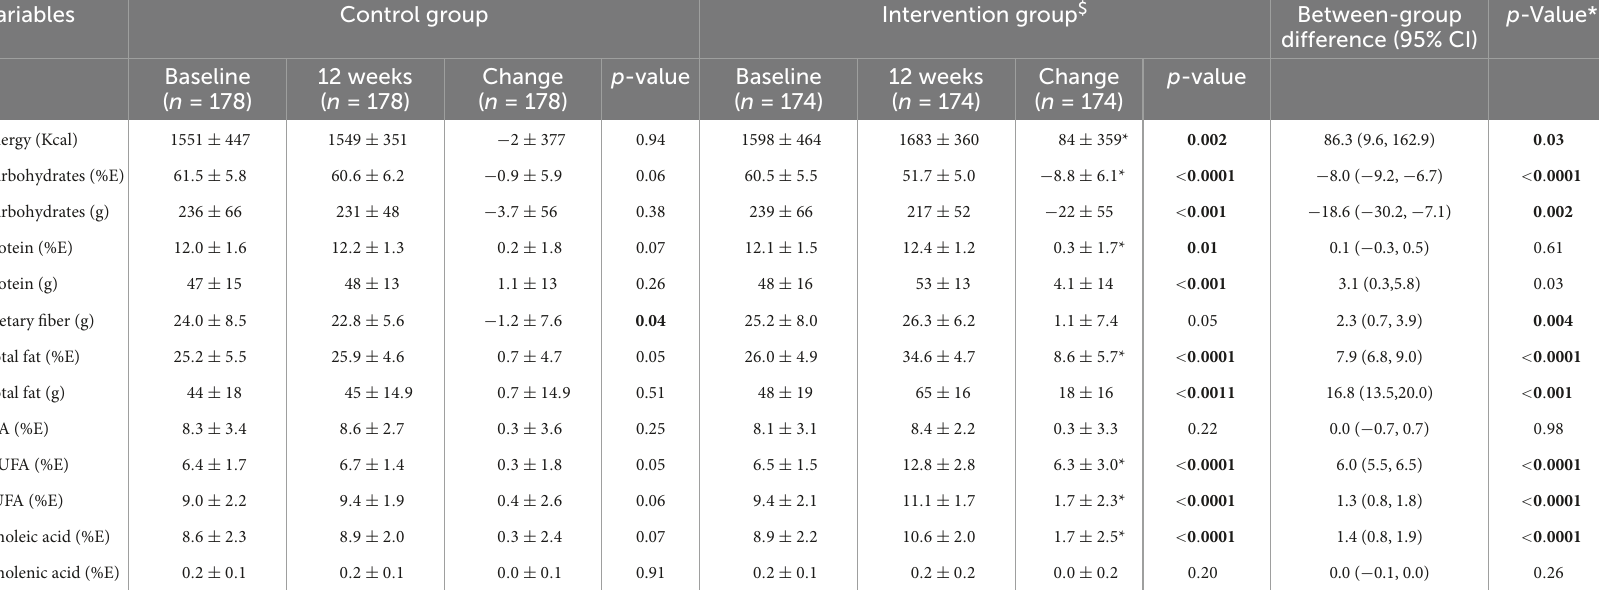
TABLE 2 Mean change in dietary characteristics of the study participants ( n =